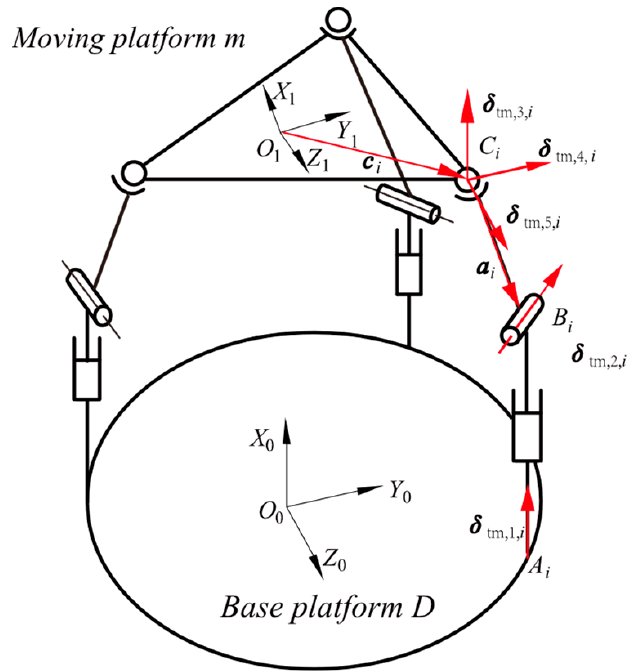
Figure 5. The vector representation of the PRS limbs.